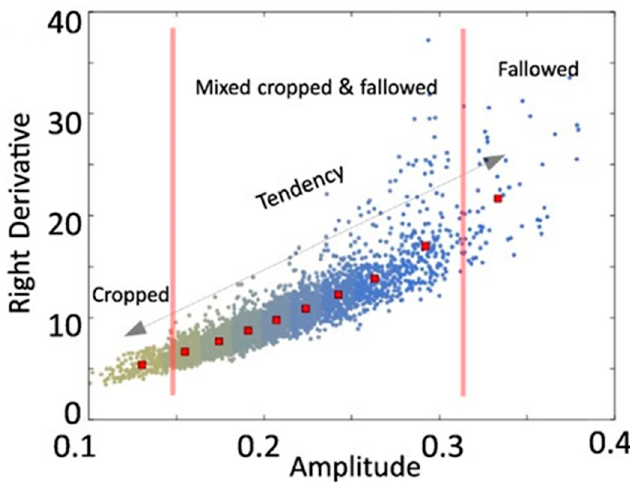
Figure 2. Scatter plots illustrating the MODIS Normalized Difference Vegetation Index (NDVI) based phenological differences between unmanured cropped and fallowed land in Niger, from Tong et al. [19]. After the rainy season, a larger amplitude and a faster decrease were observed for the fallowed fields compared to the unmanured cropped fields.